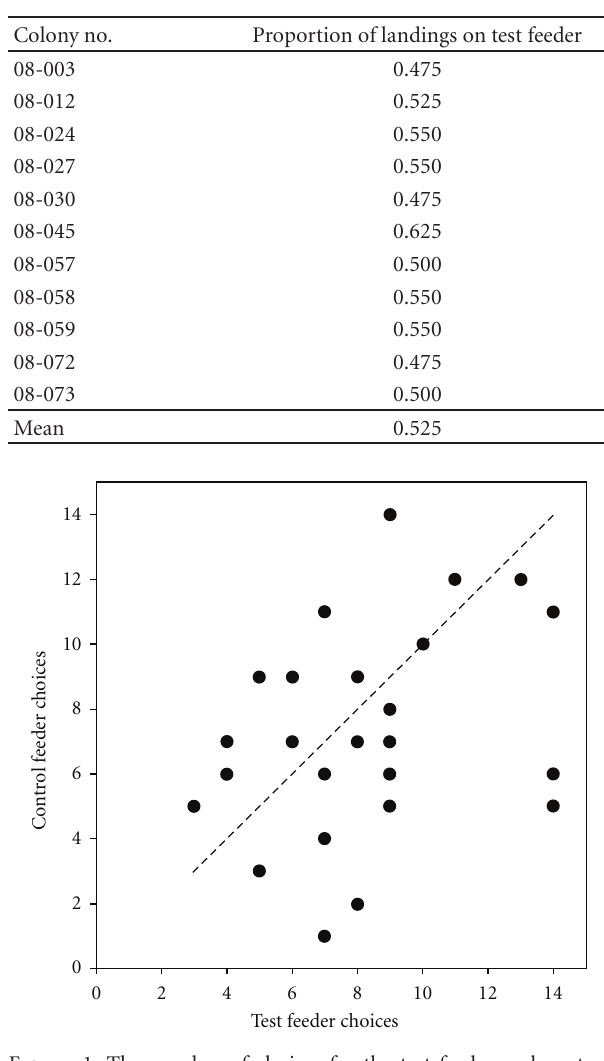
Table 1: The proportion of landings on the test feeder (40 visits per colony) for the eleven colonies tested.